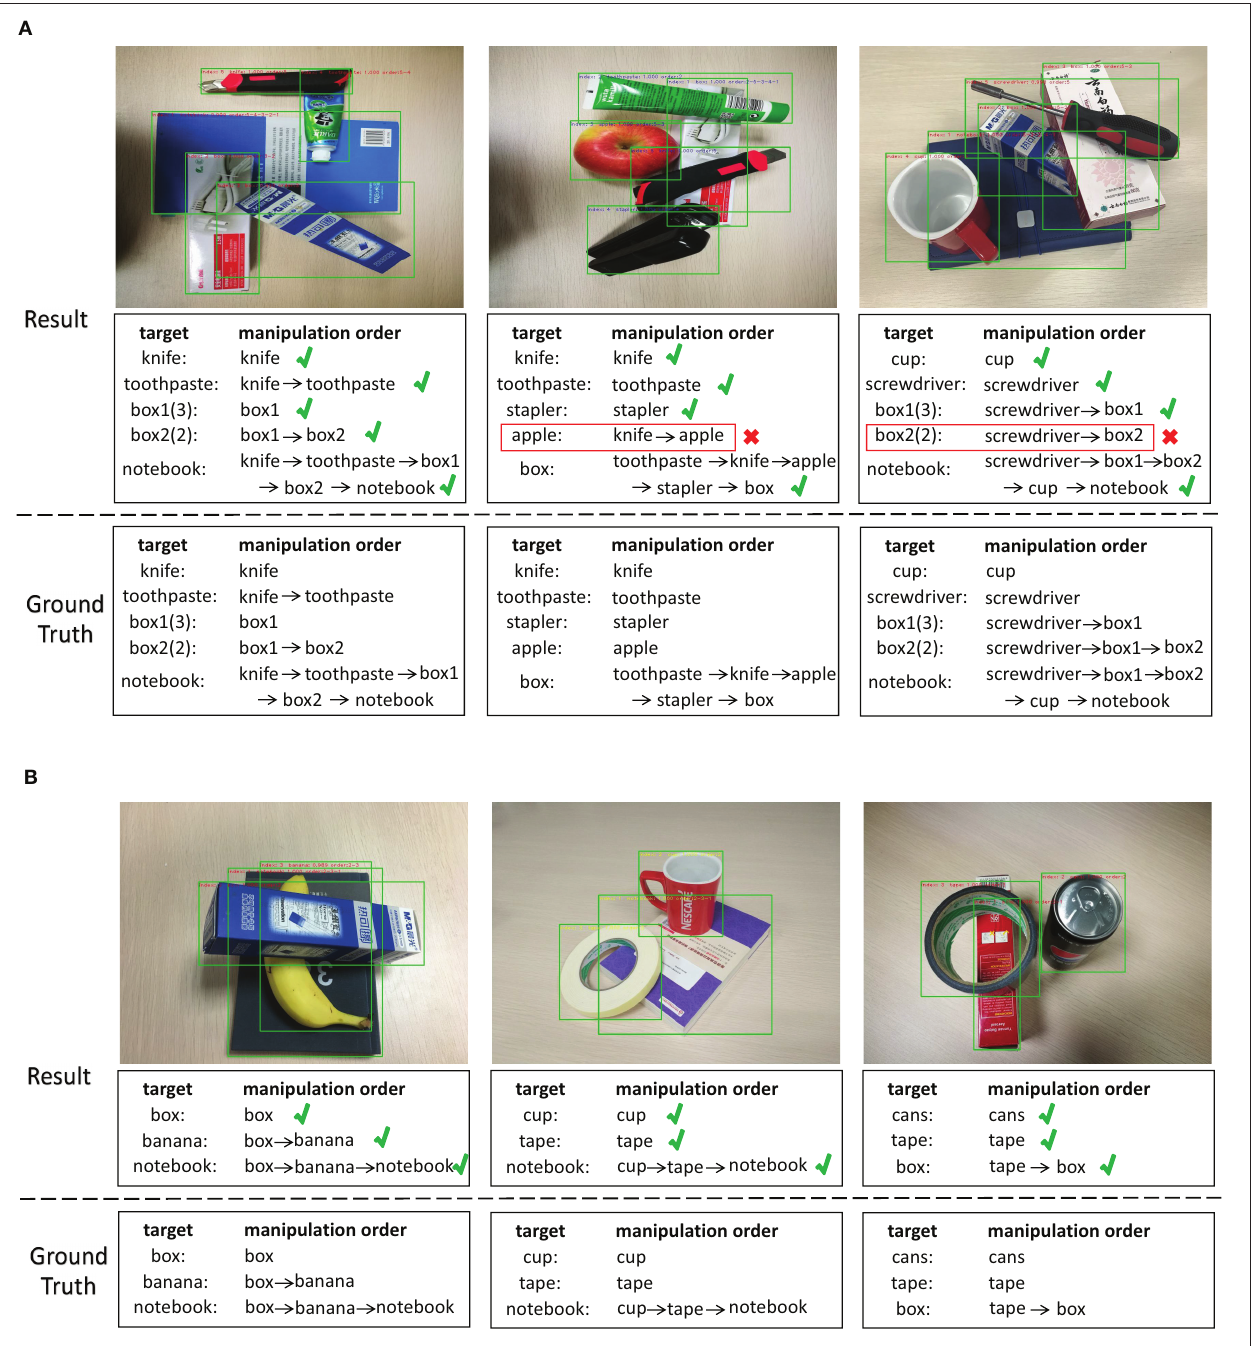
FIGURE 5 | Examples of detection results of graph-based visual manipulation relationship reasoning network on the VMRD dataset. (A) Five stacked objects in one scene, and (B) three stacked objects in one scene. The first row shows detection results of the stacked objects, and each image contains the bounding boxes of the object, the confidence score and the manipulation order. The second row shows the manipulation order in the language form of words. The third row is the ground